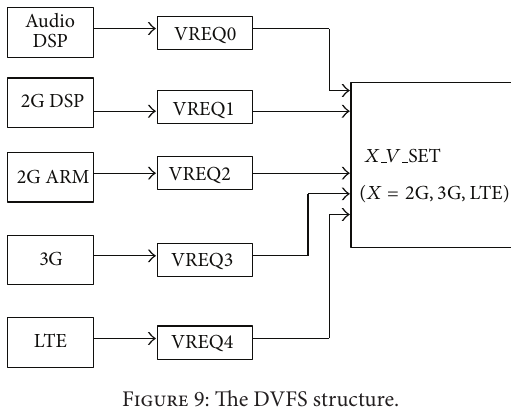
Figure 9: The DVFS structure.